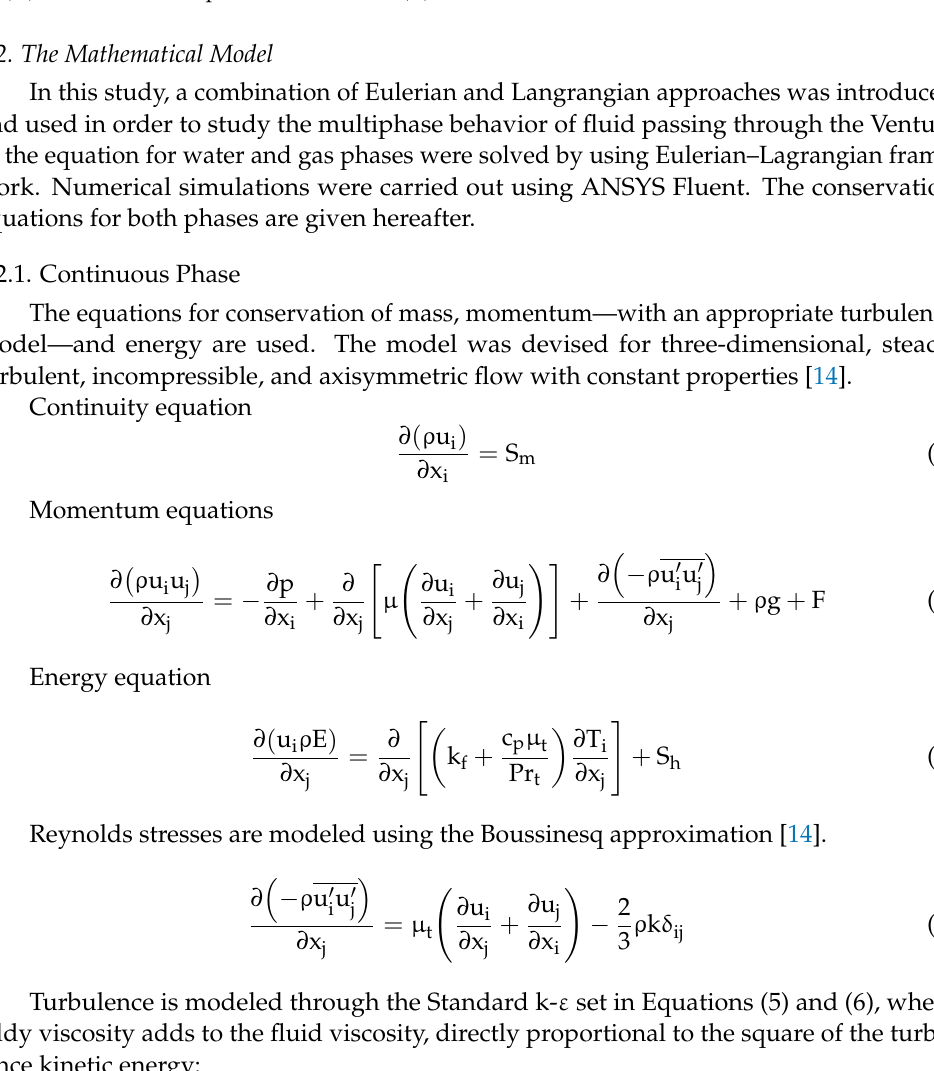
Figure 5. ( A ) Mesh of the computational domain, ( B ) mesh of the outlet section .